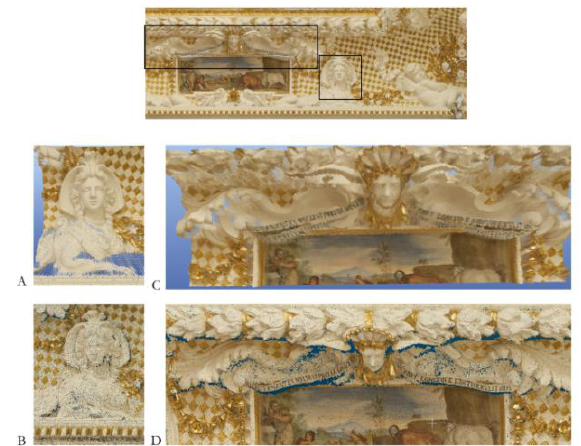
Figure. 9 Selected clouds of points of gilded details of caissons A, C – TLS , B, D - from image